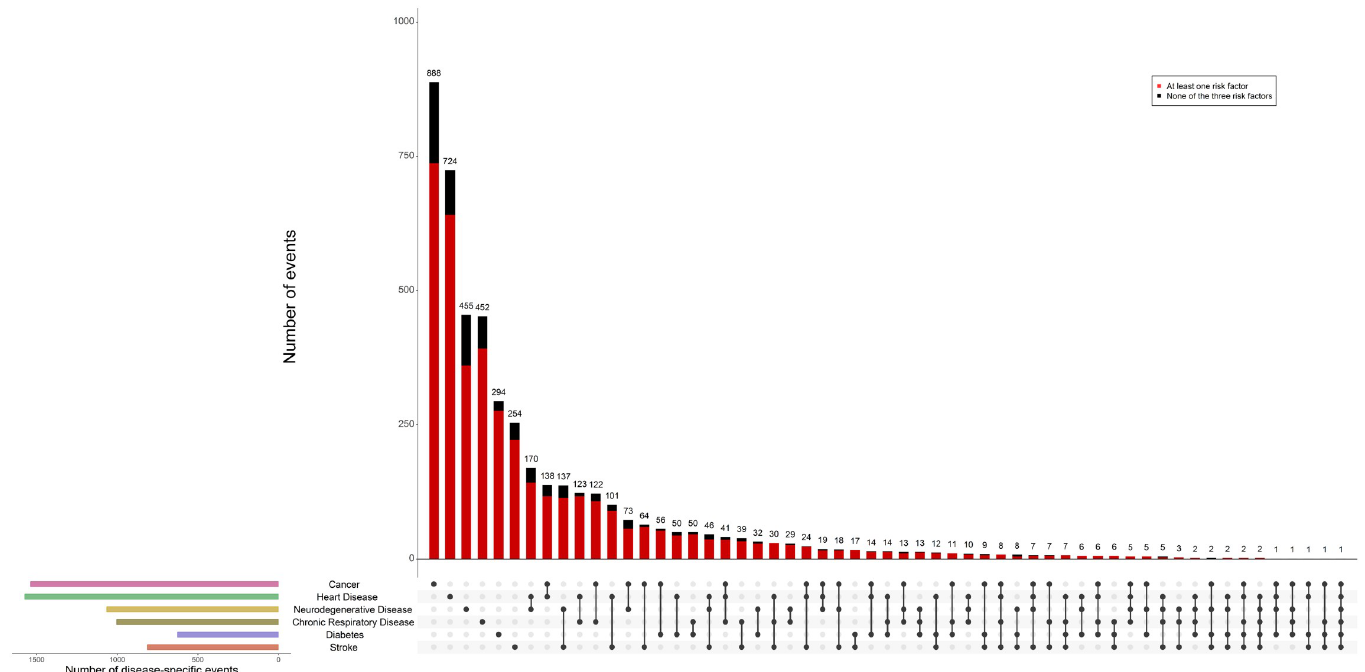
Fig 1. Intersection diagram depicting patterns of occurrence/co-occurrence of NCDs quantified as the number of events. Of all participants who developed an NCD during follow-up, a third (33.7%) were diagnosed with more than 1 of these diseases, including 1 individual who was diagnosed with all 6 diseases. The left panel displays bars for each disease separately that quantify the solitary number of events per disease, highlighting, for instance, that stroke occurred more frequently during follow-up than diabetes (814 versus 625 events, respectively). Yet stoke also showed more overlap with other NCDs compared to diabetes (254 solitary stroke events versus 294 solitary diabetes events). Events from participants who had at least 1 of the common shared risk factors (current smoking, hypertension, or overweight) at baseline are shown in red. NCD, non-communicable disease.